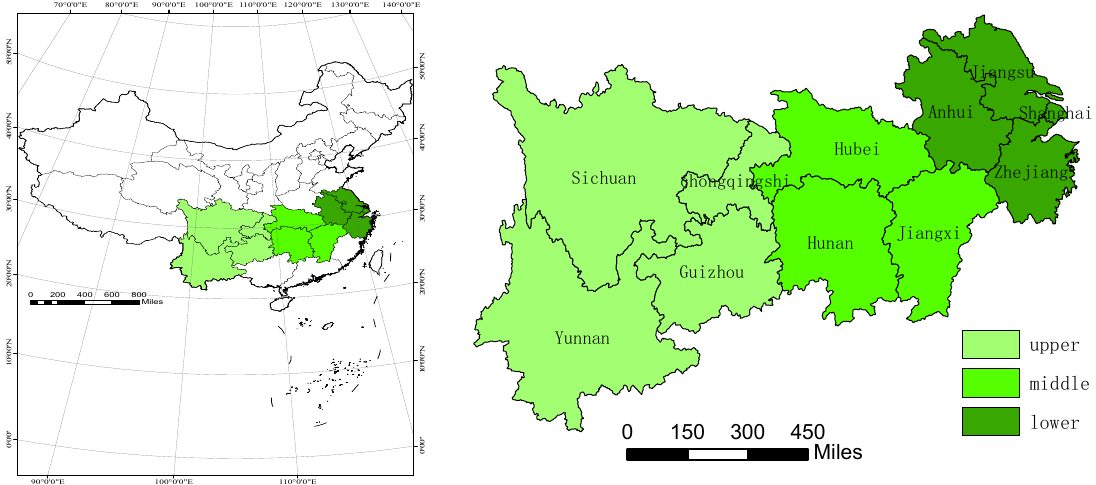
Figure 1. Map of the geographical location of the YREB in China.